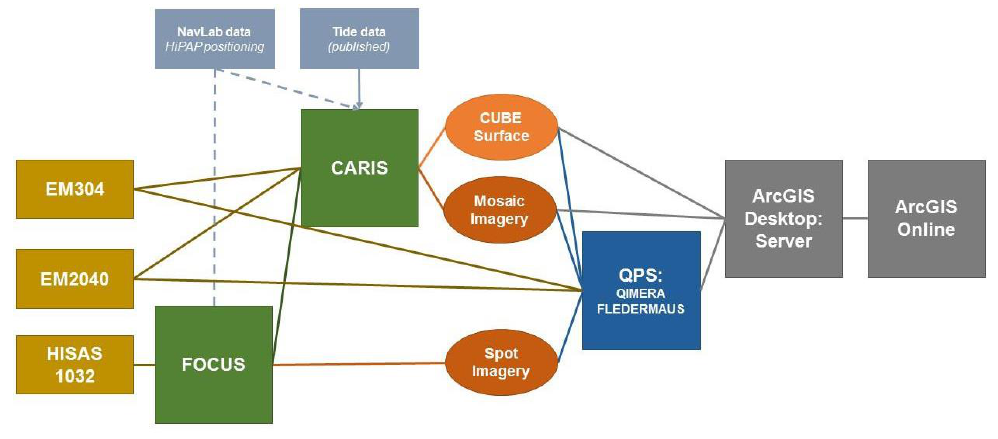
Figure 7. The scheme of simplified data processing